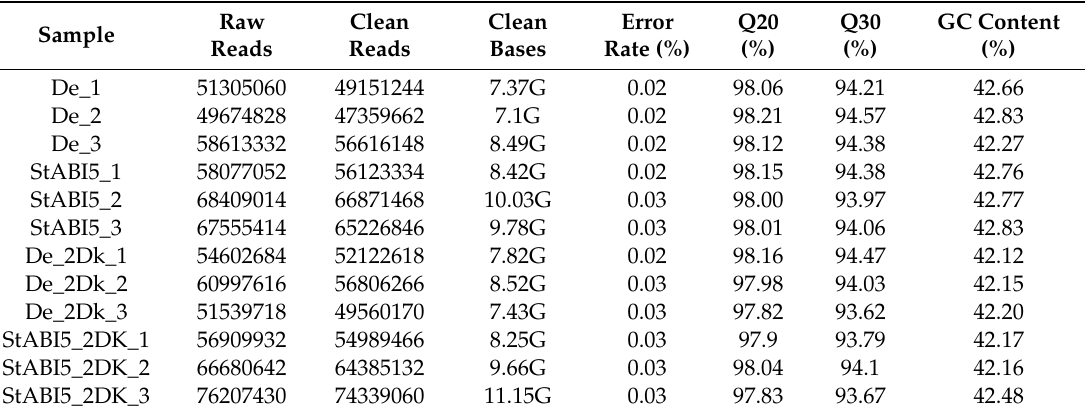
Table 1. Summary of RNA-seq